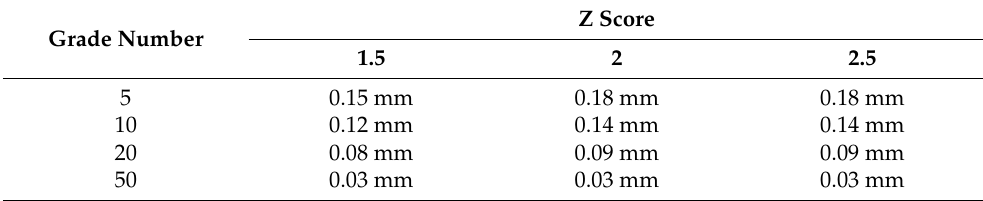
Table 7. Relationship between widths and z-scores of different